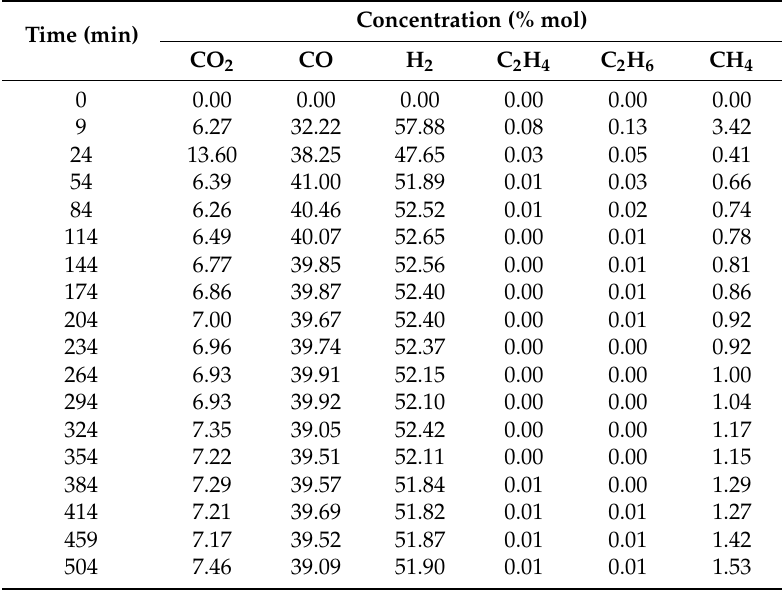
Table 7. Gas composition from GC